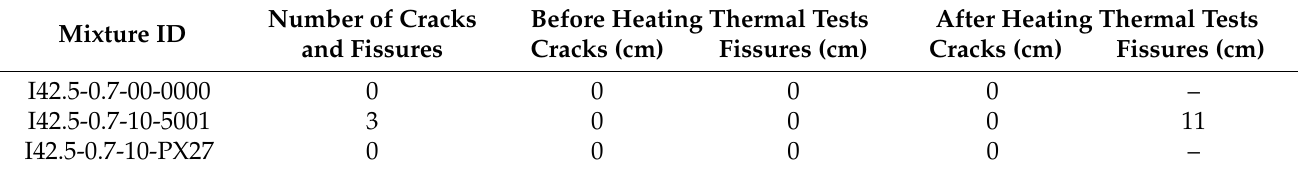
Figure 6. Micronal DS5001 X samples: original probe ( left ) and heated probe ( right ). Table 8. Crack and fissures results of samples with different